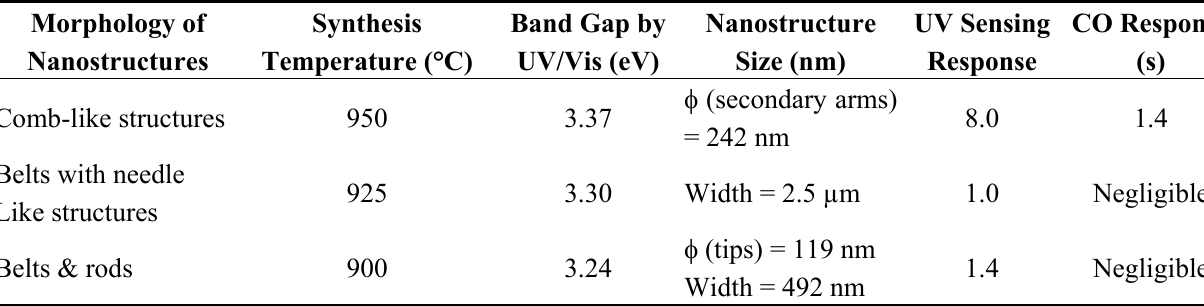
Table 1. Detailed summary of the